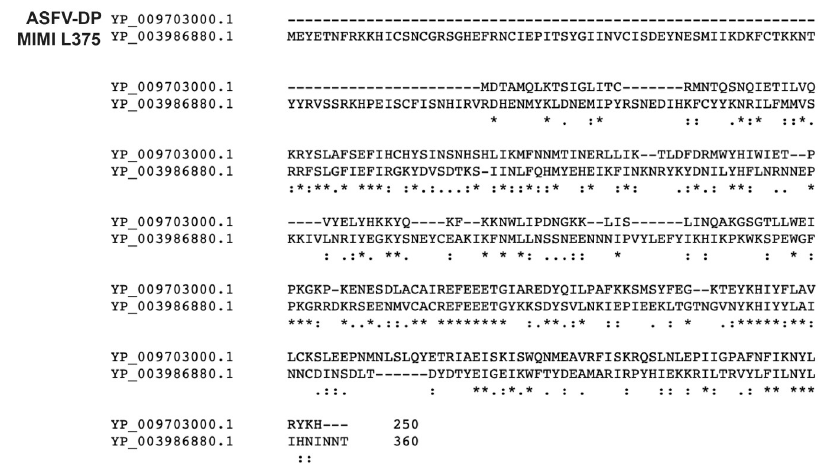
Fig 1. Mimivirus L375 shares sequence similarity with ASFV-DP. A Clustal Omega alignment of Mimivirus L375 (NCBI ID: YP_003986880) and ASFV-DP (NCBI ID: YP_009703000.1) shows regions of conserved amino acid sequence between the two